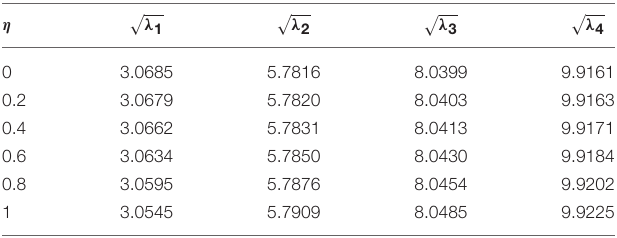
TABLE 15 | Frequency parameter parameters.